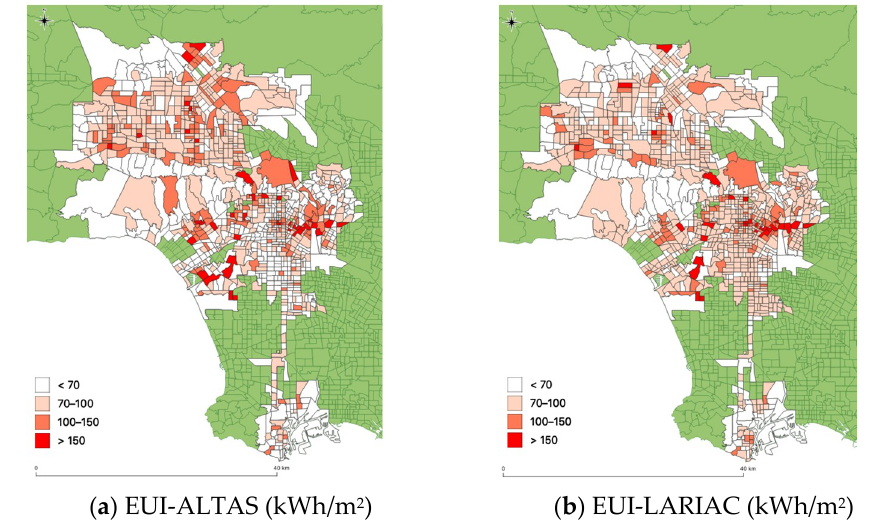
Figure 7. Census tracts building annual EUI distribution. ( a ): EUI-ALTAS (kWh / m 2 ), ( b ) EUI-LARIAC (kWh / m 2